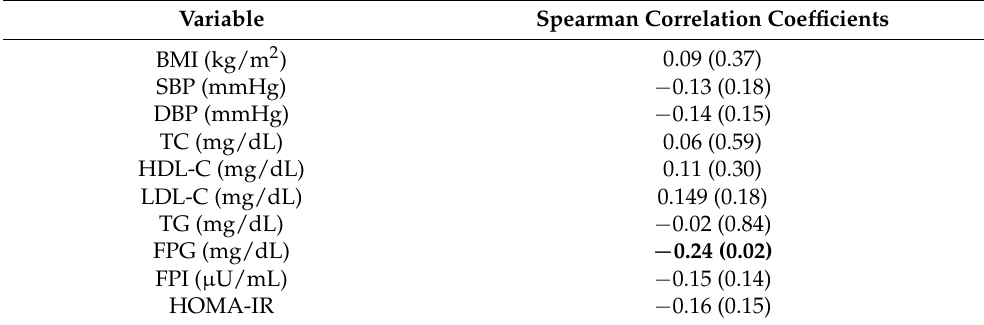
Table 2. Correlation between serum Se level and cardiometabolic traits.